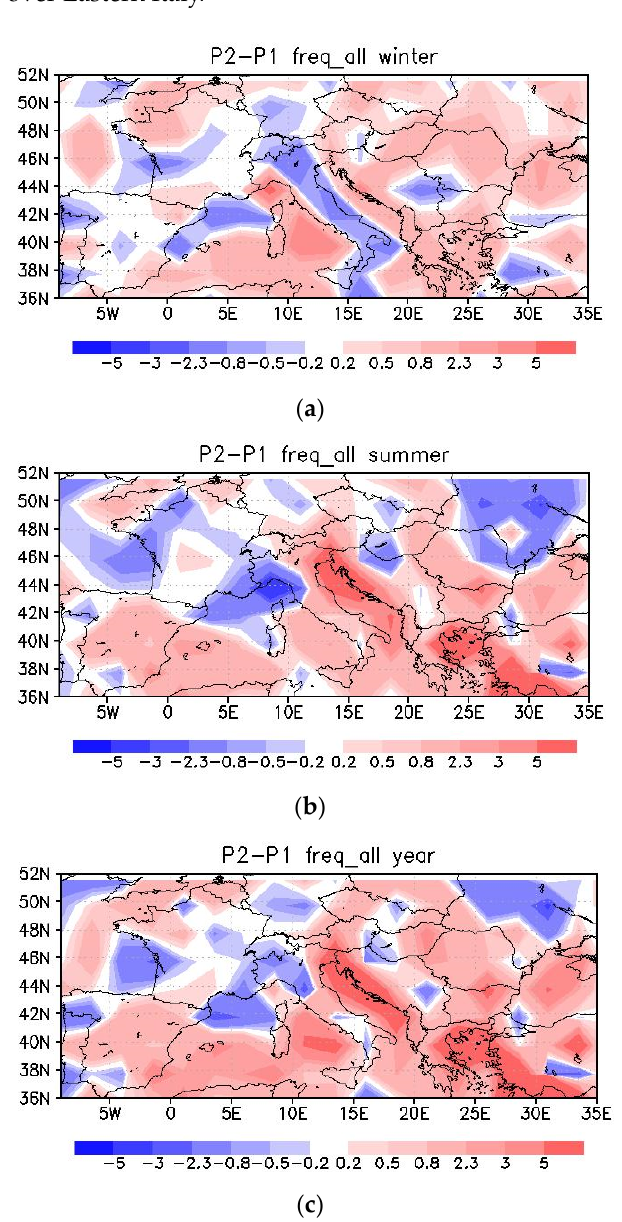
Figure 2. Change in the total number of cyclone tracks over Europe (origins in “EU”), as mean difference (P2–P1); the mean is determined over model grid-points (0.75°) in 2.5° E × 2° N boxes and summed over time for: winter ( a ), summer ( b ), and year ( c ).